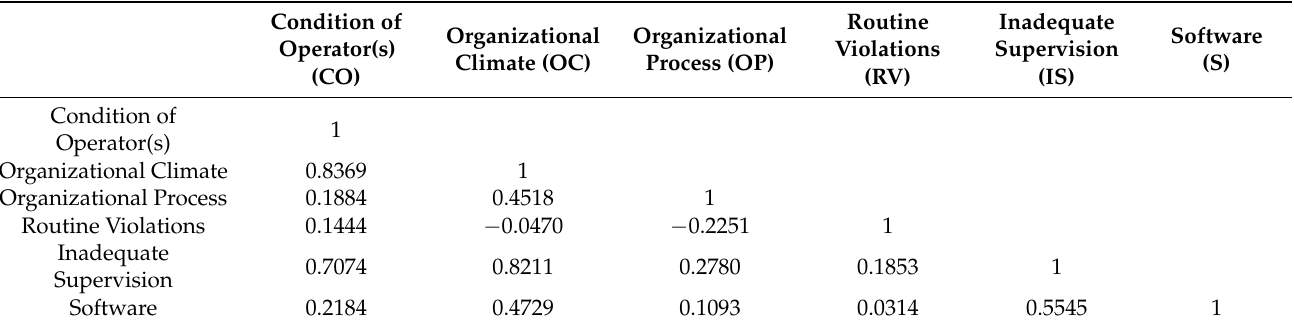
Table 4. Explanatory variables correlation